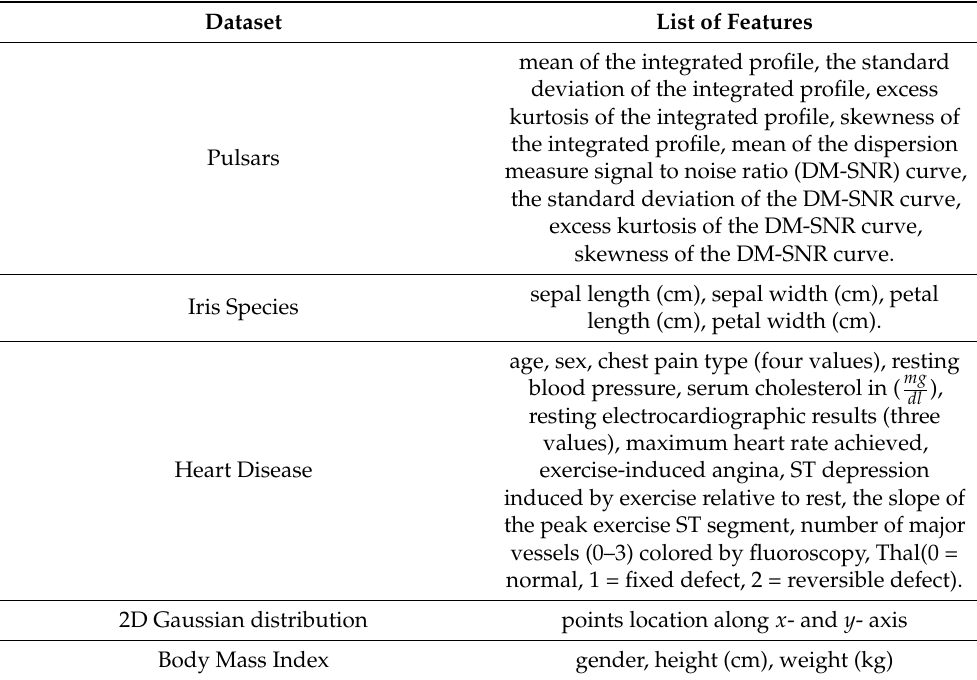
Table 3. List of datasets used as use cases for our experiments. Dataset List of Features mean of the integrated profile, the standard deviation of the integrated profile, excess kurtosis of the integrated profile, skewness of the integrated profile, mean of the dispersion Pulsars measure signal to noise ratio (DM-SNR) curve, the standard deviation of the DM-SNR curve, excess kurtosis of the DM-SNR curve, skewness of the DM-SNR curve. sepal length (cm), sepal width (cm), petal Iris Species length (cm), petal width (cm). age, sex, chest pain type (four values), resting blood pressure, serum cholesterol in ( mg ), dl resting electrocardiographic results (three values), maximum heart rate achieved, exercise-induced angina, ST depression Heart Disease induced by exercise relative to rest, the slope of the peak exercise ST segment, number of major vessels (0–3) colored by fluoroscopy, Thal(0 = normal, 1 = fixed defect, 2 = reversible defect). 2D Gaussian distribution points location along x - and y - axis Body Mass Index gender, height (cm), weight